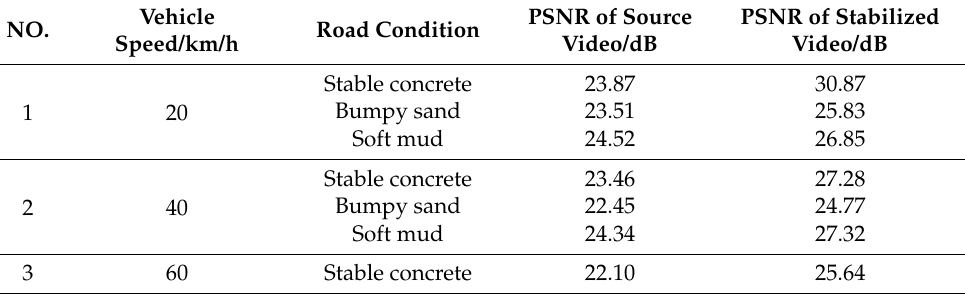
Figure 22. Six sample frames in the videos captured at the speed of 20 km/h, and 40 km/h. Table 2. PSNR values for three road conditions at the speed of 20 km/h, 40 km/h, and 60 km/h.